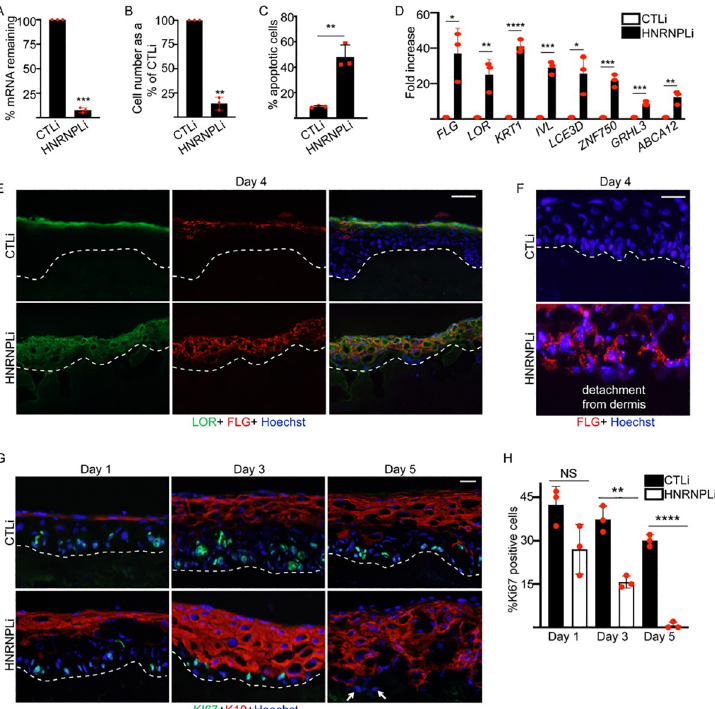
Fig 1. HNRNPL is required for maintaining epidermal progenitor cell function. (A) Primary human keratinocytes were knocked down with control (CTLi) or HNRNPL (HNRNPLi) siRNAs, and the remaining HNRNPL mRNA levels were measured using RT-qPCR. qPCR results were normalized to L32 levels. (B) CTLi and HNRNPLi cells were seeded at 150,000 cells and counted 4 days later. Cell number was reported as a percentage of CTLi levels. (C) Annexin V staining was used to determine the percentage of apoptotic cells in CTLi and HNRNPLi cells after 4 days of culture. (D) RT-qPCR for epidermal differentiation gene expression in CTLi and HNRNPLi cells after 4 days of knockdown. qPCR results were normalized to L32 levels. (E) Regenerated human skin using three-dimensional organotypic cultures made from CTLi or HNRNPLi cells were harvested after 4 days of culture. Immunostaining of late differentiation proteins LOR (green) and FLG (red) are shown. Nuclei are shown in blue (Hoechst staining). The dashed white lines denote the basement membrane zone. Scale bar = 40 μ m. (F) High magnification images of day 4 regenerated human skin in CTLi and HNRNPLi samples. Staining of FLG (red) merged with nuclei (Hoechst) is shown. Scale bar = 10 μ m. (G) Time course (days 1, 3, and 5) of human skin regeneration. Immunostaining of CTLi or HNRNPLi regenerated human skin with early differentiation marker K10 (red) and proliferation marker KI67 (green). White arrowheads denote rare basal layer cells not stained with K10 in HNRNPLi samples. Scale bar = 10 μ m. (H) Quantification of the percentage of Ki67 positive cells in the basal layer from (G). N = 3 independent experiments for all of Fig 1. Mean values are shown with error bars = SD. � p < 0.05, �� p < 0.01, ��� p < 0.001, ���� p < 0.0001 ( t test). NS, not significant. Primary data for this figure can be found in S1 Data. FLG, filaggrin; HNRNPL, heterogeneous nuclear ribonucleoprotein L; K10, keratin 10; LOR, loricrin; RT-qPCR, reverse transcription quantitative PCR; siRNA, small interfering